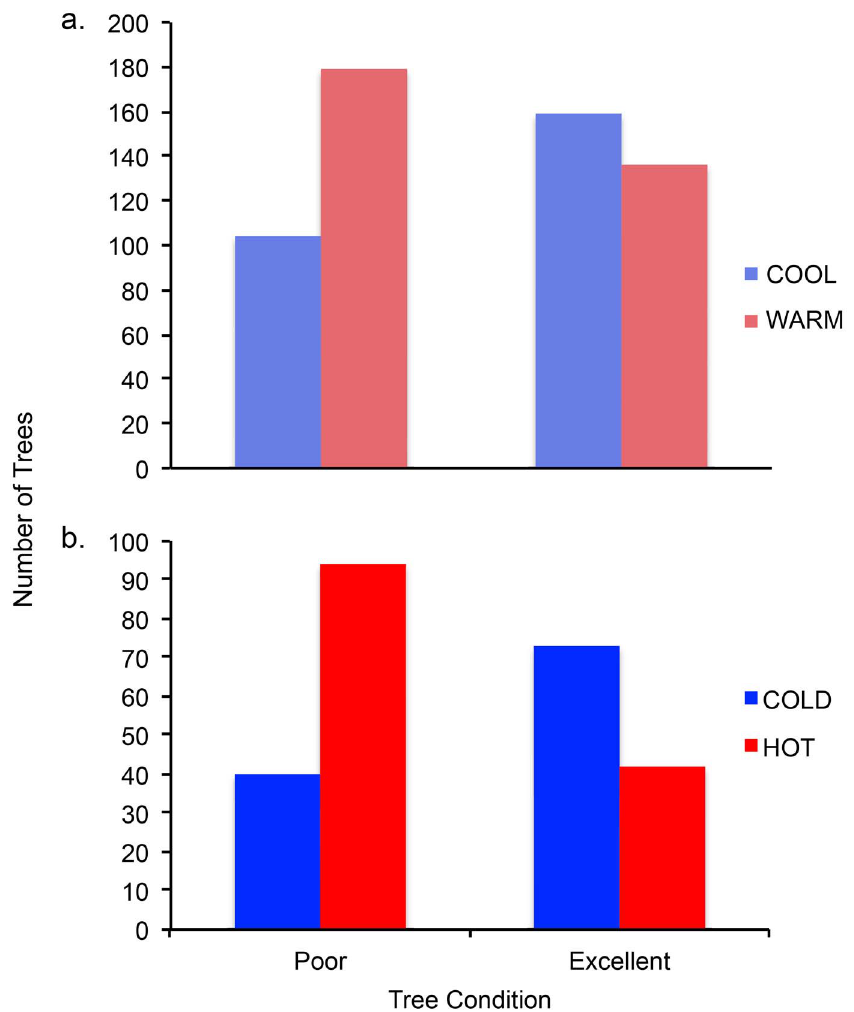
Figure 5. Pairwise comparison (a) of the number of trees with ‘‘Poor’’ and ‘‘Excellent’’ condition ratings between ‘‘Warm’’ and ‘‘Cool’’ median temperature classification (P , 0.0001). Pairwise comparison (b) of the number of trees with ‘‘Poor’’ and ‘‘Excellent’’ condition ratings between ‘‘Hot’’ and ‘‘Cold’’ quartile temperature classification (P , 0.0001).